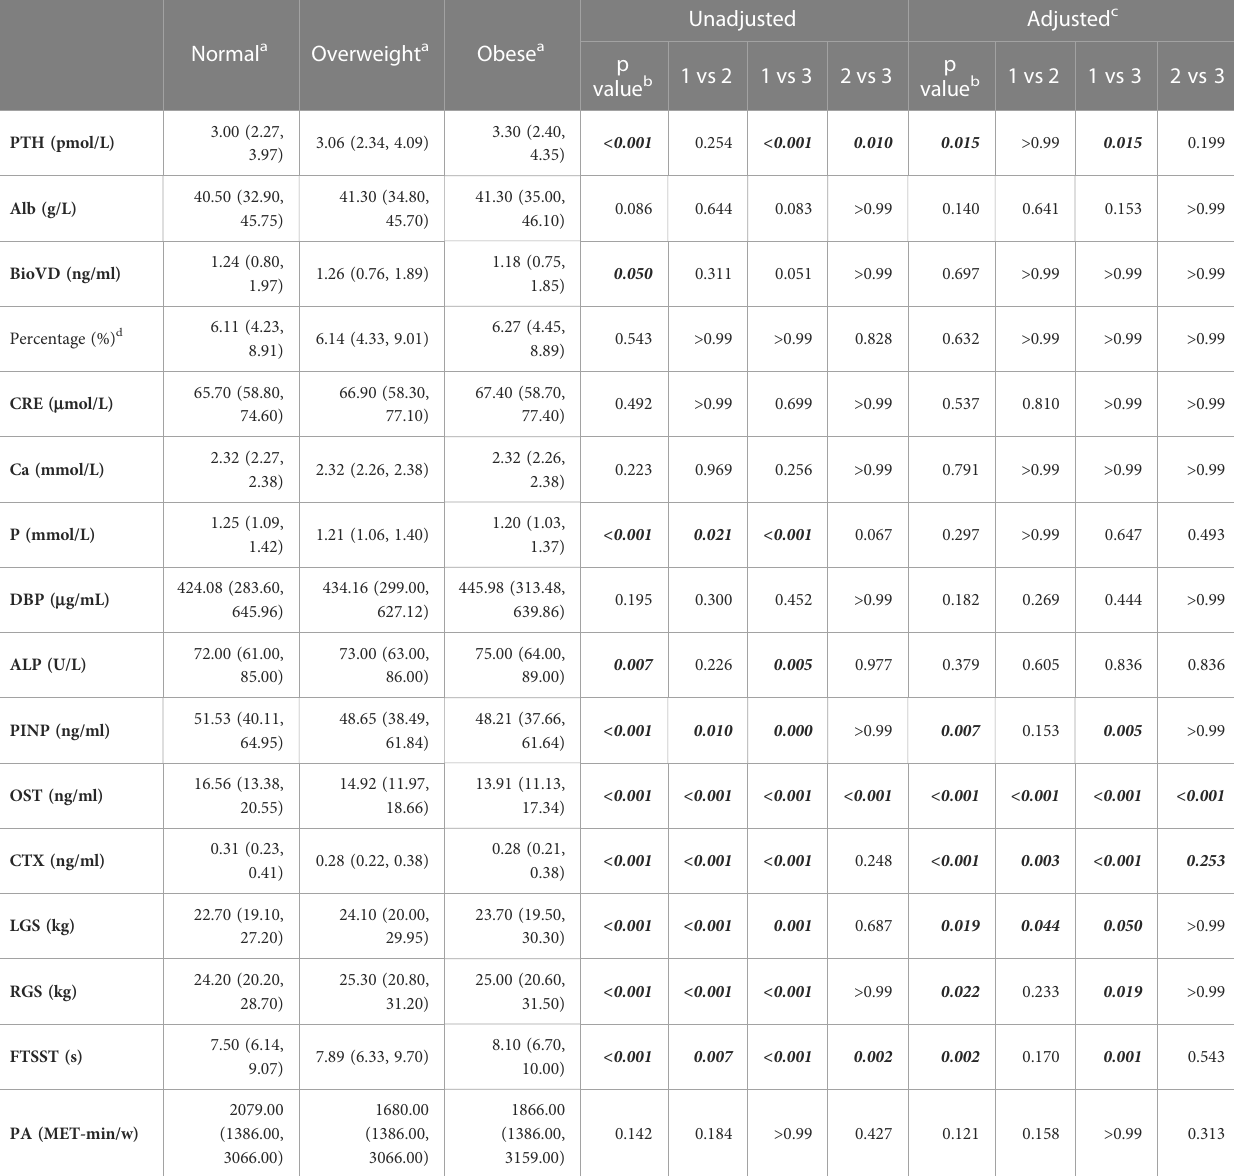
Normal a Overweight a Obese a